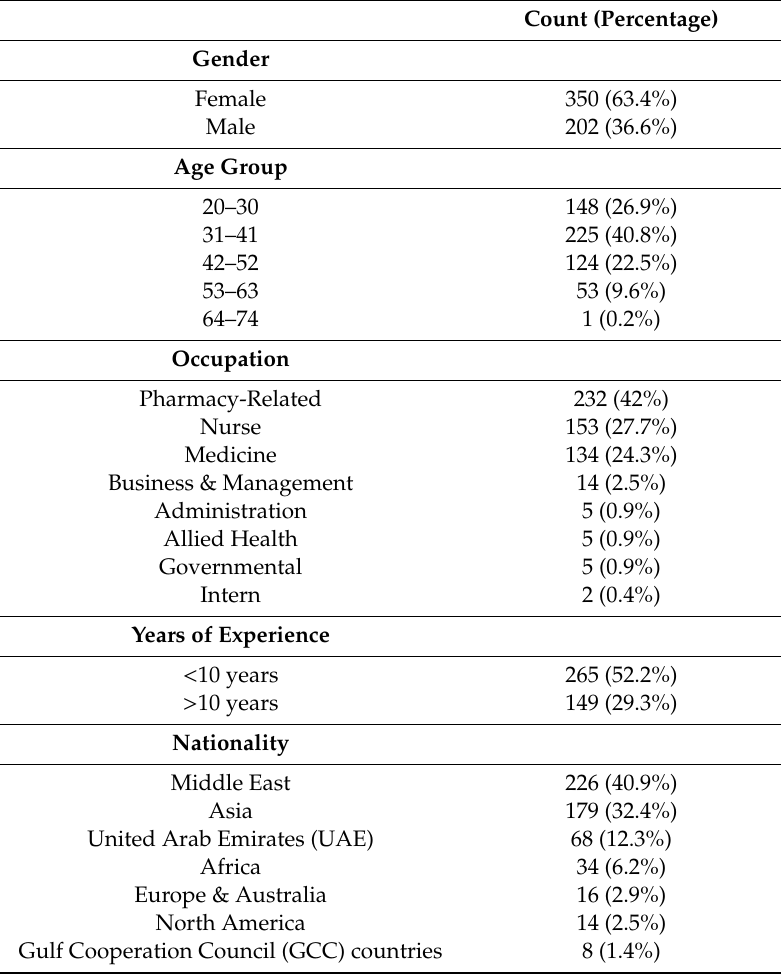
Table 1. Demographic characteristics of healthcare workers ( N = 552).